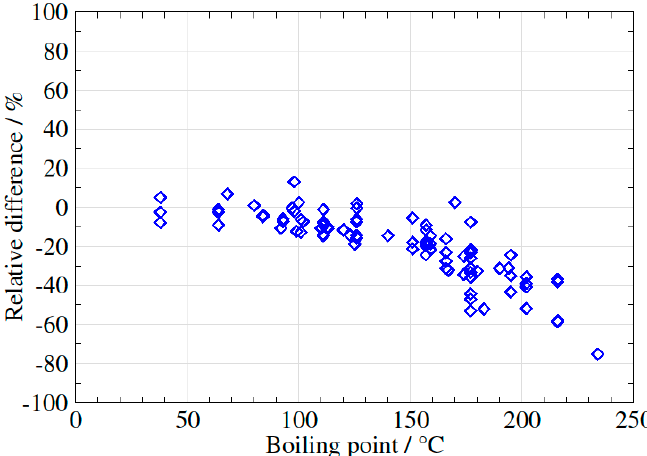
Figure 7. Difference in VOCs concentrations measured with the sampling pump method versus the